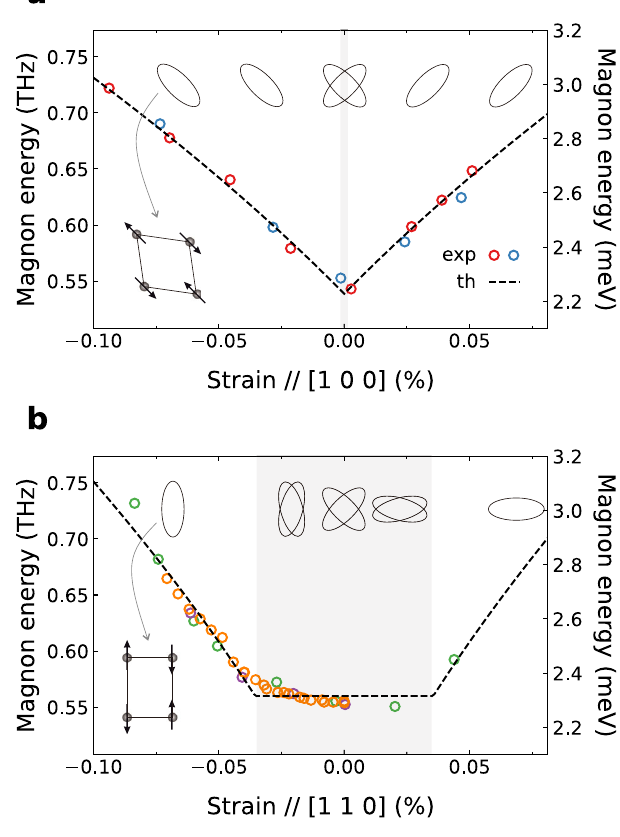
Fig. 3 | Response of magnon energies to uniaxial stress. Magnon energy as a functionofuniaxialstrainalongthe a [100]and b [110]axes.Circleswithdifferent colors represent data points measured from different samples. They are vertically shifted by the following magnitudes (in THz): red(0), blue(0.02), green(0), orange(0.02), and magenta(0.04). Different vertical shifts are likely due to slightly different sample qualities. Dashed lines are derived from the pseudospin-lattice coupling theory. Ellipses represent (exaggerated) orthorhombically-distorted magnetic domains, as illustrated on the lower left side of each fi gure. Two ellipses on top of each other correspond to two degenerate domains, coexisting in the shaded regions.